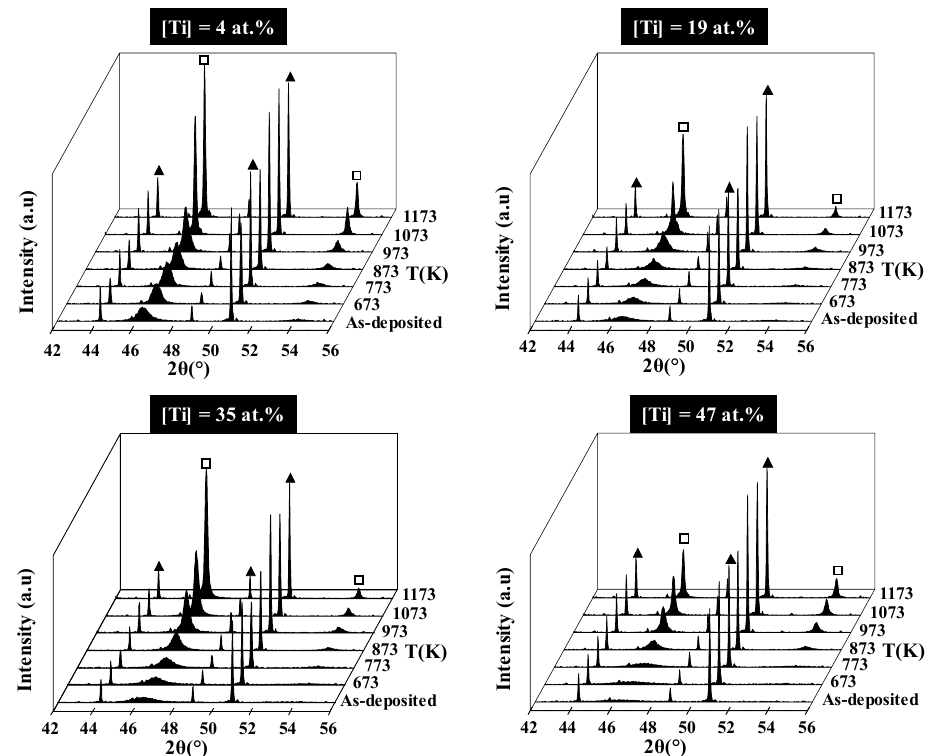
Figure 5. XRD patterns as function of the annealing treatment for different titanium concentrations ( Pt 3 Ti, alumina).